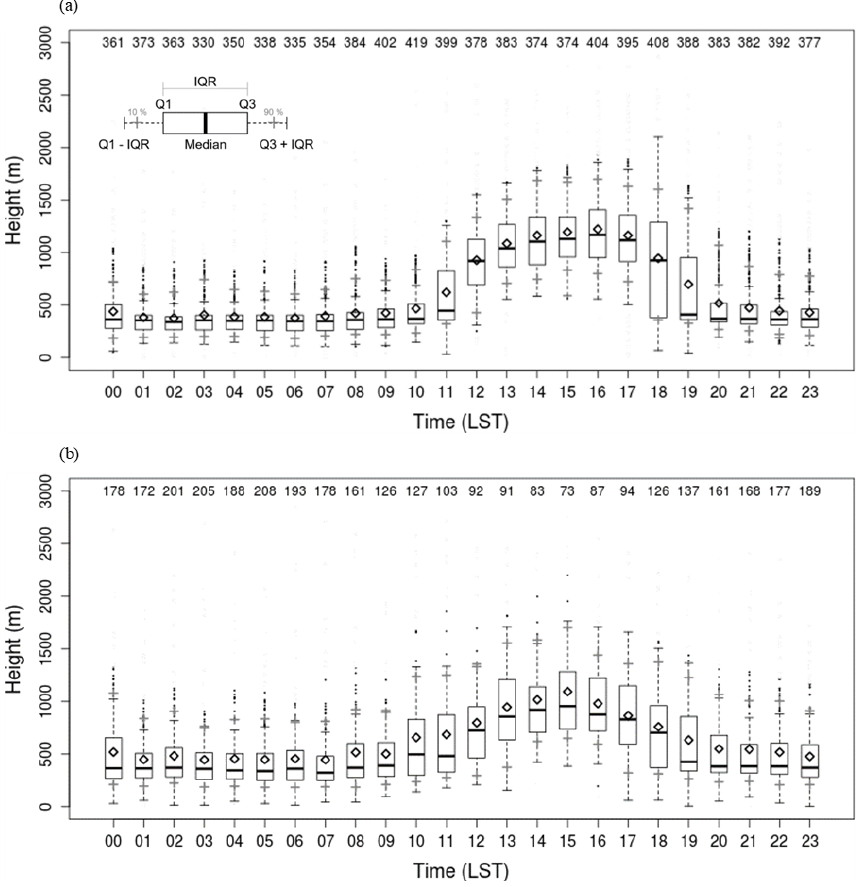
Figure 12. Box plots of hourly ABLHs estimated by ISABLE on (a) clear (cloud cover ≤ 30%) and (b) cloudy (cloud cover ≥ 80%) cases for the period from August 2016 to October